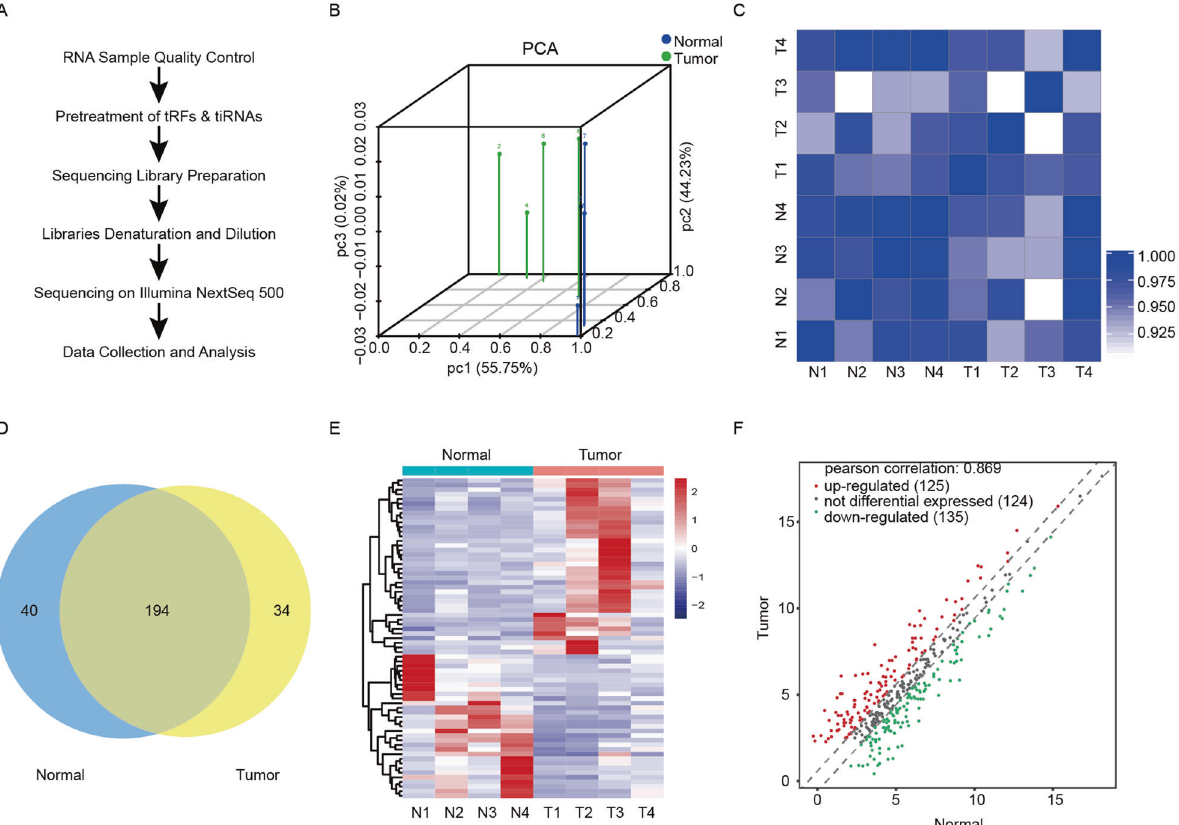
Fig. 1 The overview of the tRFs and tiRNAs expressions in four GC tissues and paired normal tissues is shown. A The work fl ow of tRFs and tiRNAs sequencing and data analysis. B The principal component analysis (PCA) of tRFs and tiRNAs expressions in tumor and normal samples. C The correlation coef fi cient analysis of tRFs and tiRNAs expressions in tumor and normal samples. D Venn diagram of tRFs and tiRNAs expressions in tumor and normal groups. E Heatmap of tRFs and tiRNAs in tumor and normal groups. F Scatter plot of tRFs and tiRNAs in tumor and normal